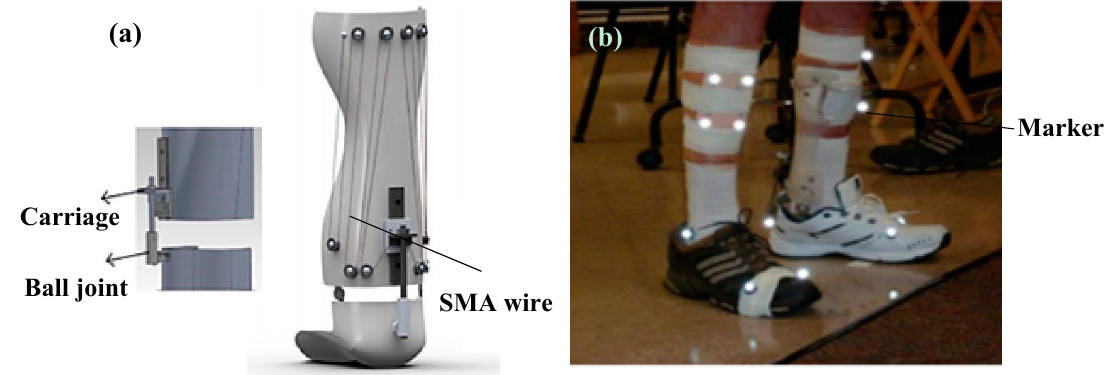
Figure 21. ( a ) The SMA passive AFO prototype, and ( b ) the motion analysis test on the patient wearing the SMA AFO [51].